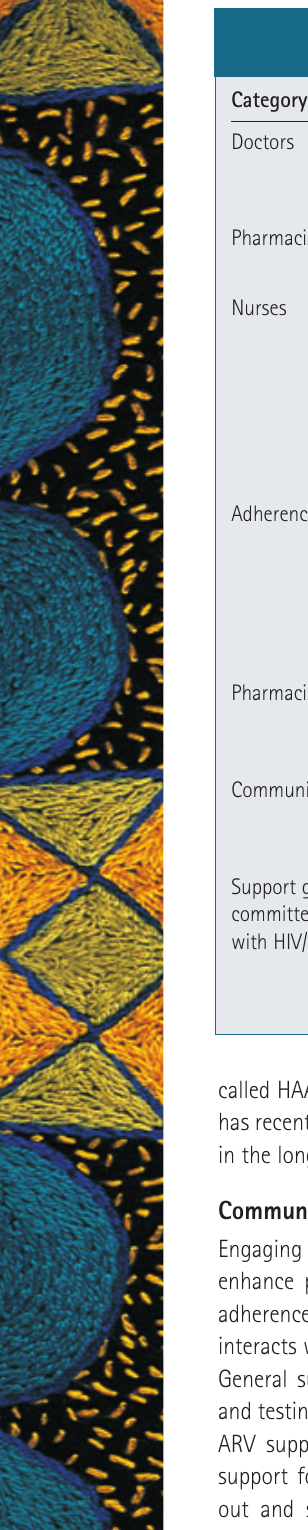
TABLE III. COMPARISON OF THE TRADITIONAL ROLES OF HEALTH STAFF IN HIV/AIDS CARE COMPARED